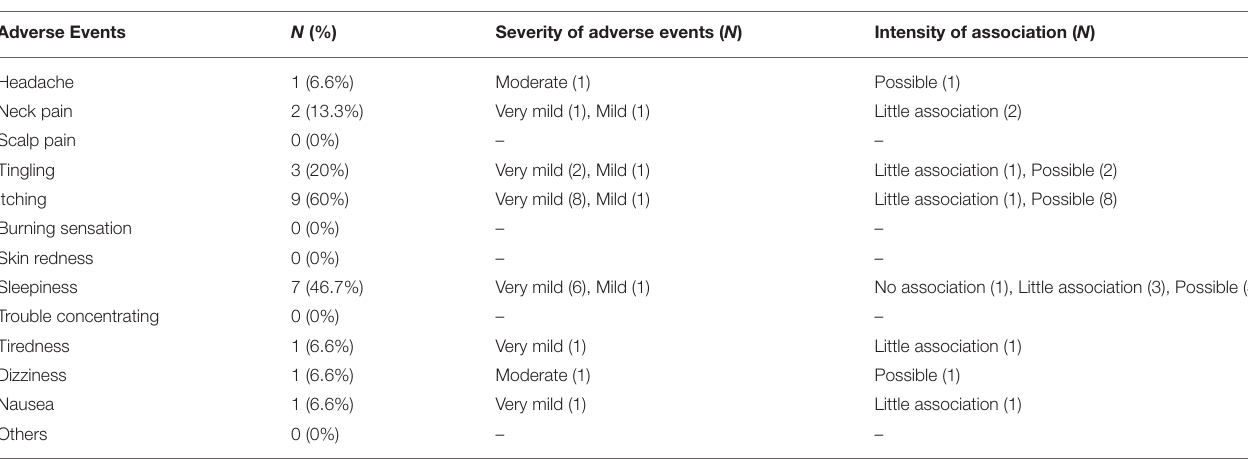
TABLE 6 | Adverse events related to tDCS reported by